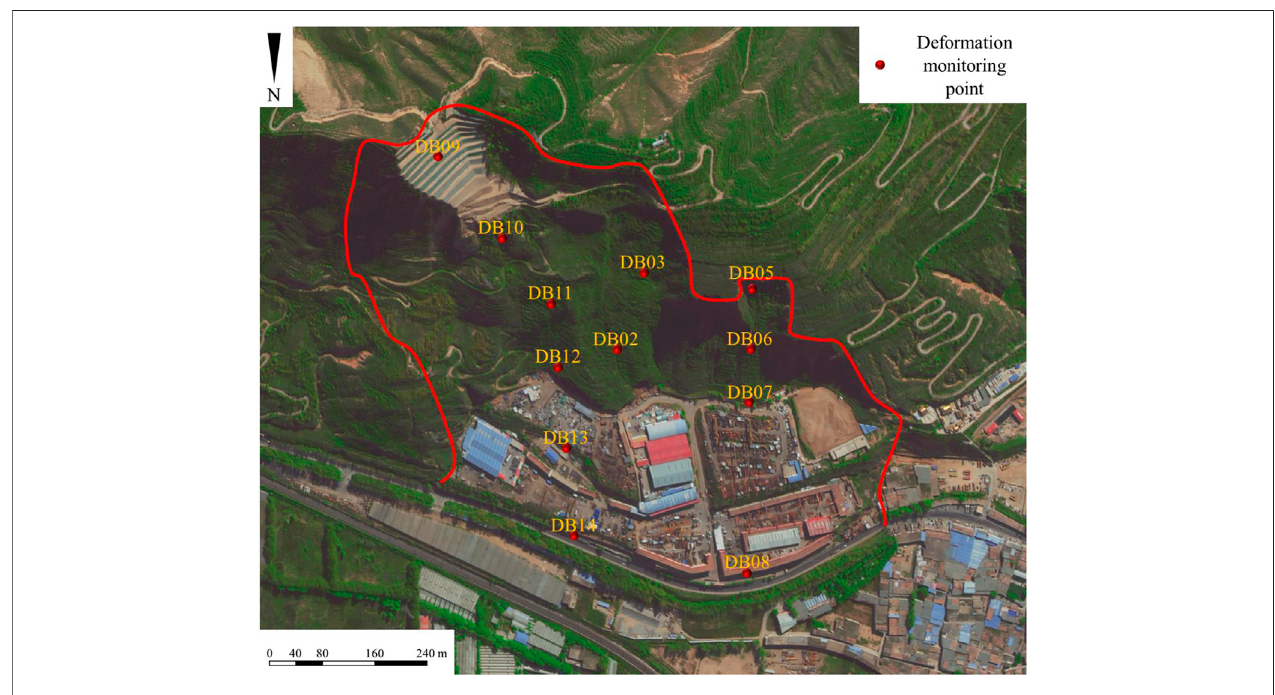
FIGURE 1 | Case study area in Zhangjiawan